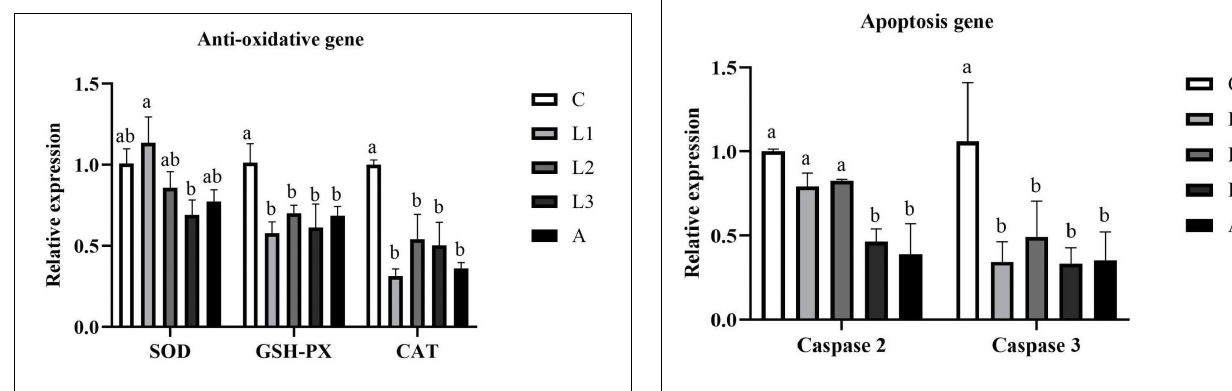
FIGURE 1 | Hepatopancreas RNA expression level of antioxidative genes of L. vannamei fed diet supplementation with/without lutein or astaxanthin for 56 days.